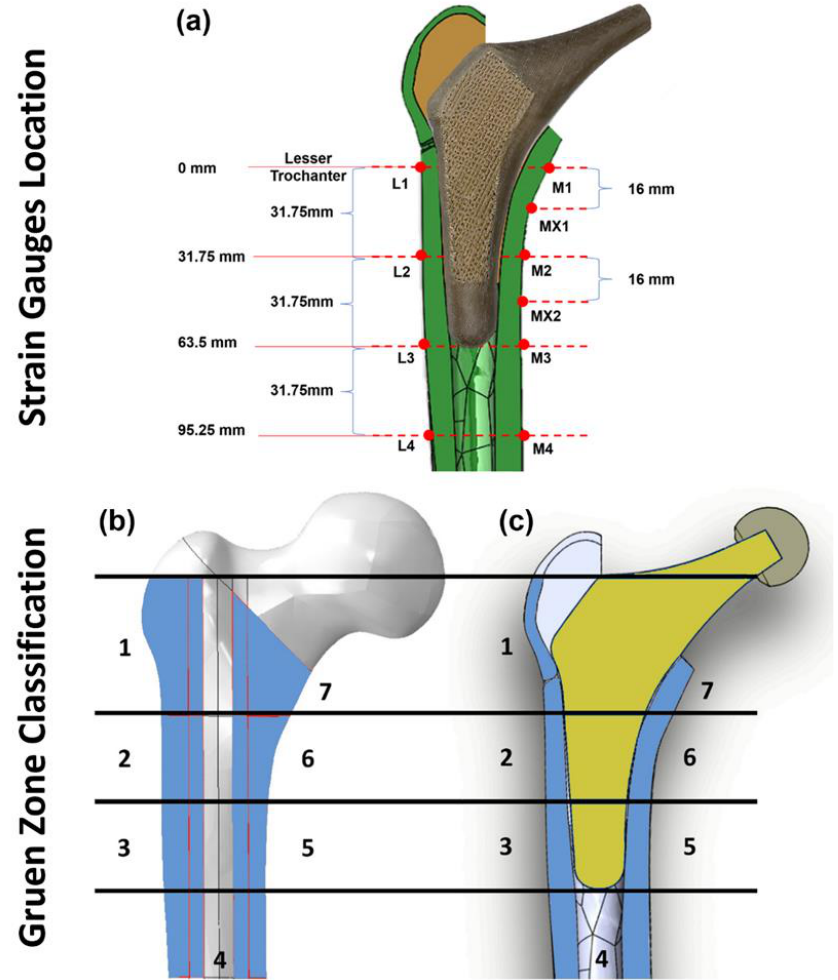
Figure 5. Illustration of strain gauge locations on the surface of the cortical bone (a – b), Gruen zones (1 – 7) on intact femur bone model (c), and section view of the implanted hip stem inside the femur Sawbone (d).